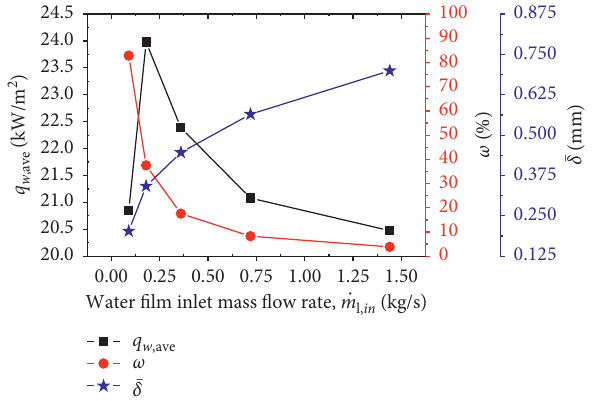
Figure 7: Influence of the water film inlet mass flow rate on heat and mass transfer of the water film evaporation process.